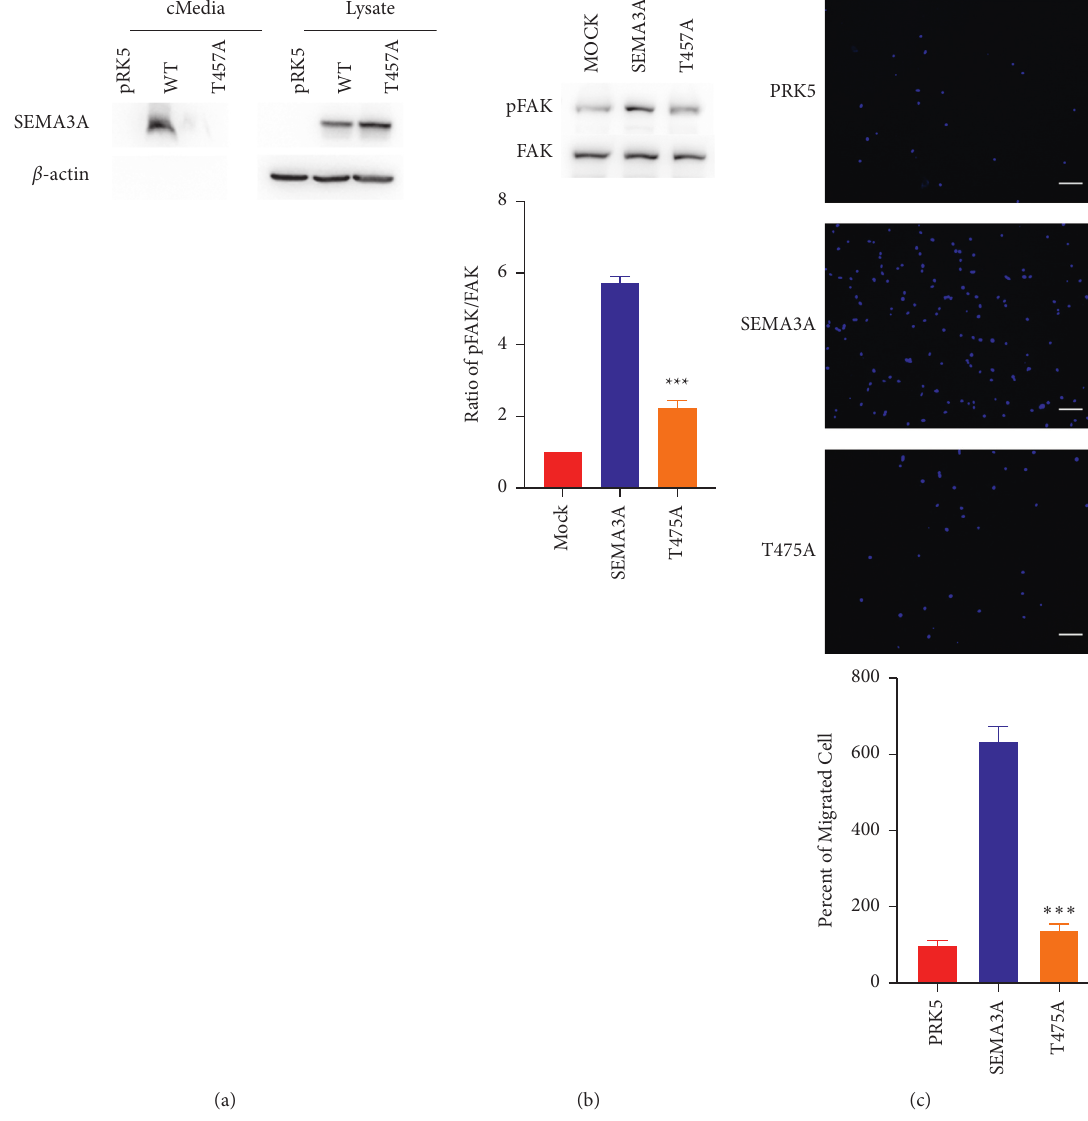
Figure 2: Functional study of the novel SEMA3A variant. (a) Expression and secretion of WT SEMA3A protein and T457A mutant protein. (b) Above: GN11 cells incubated with the serum-free medium (mock, negative control) or conditioned medium containing WTand mutated SEMA3A protein for 20 minutes. The phosphorylated FAK (pFAK) and total FAK in GN11 cells detected by Western blot. Below: the bar chart shows the ratio of pFAK to total FAK. ∗∗∗ P < 0 . 005. (c) Above: transwell assay of GN11 cells incubated with the serum-free medium (pRK5, negative control) or the conditioned medium containing WT and mutated SEMA3A protein. Below: the statistic analysis of the transwell assay ∗∗∗ P < 0 . 005. Scale bars: